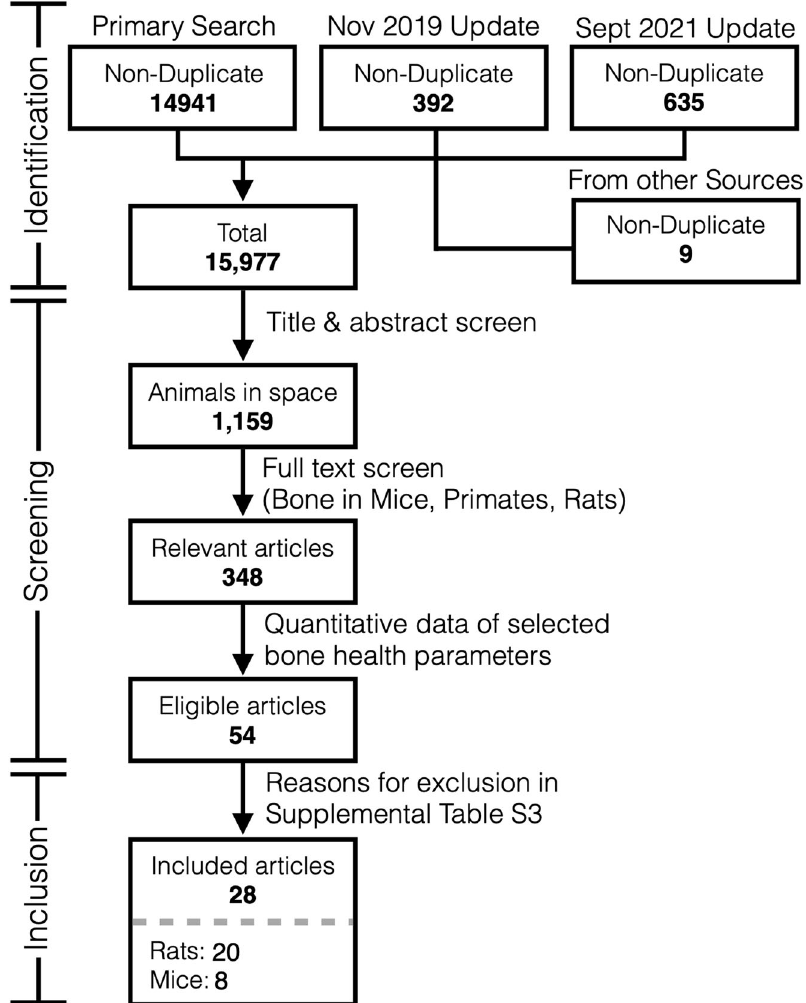
Fig. 1 Systematic review information fl ow. Prisma diagram indicated the numbers of records assessed duringdifferent steps of the systematic